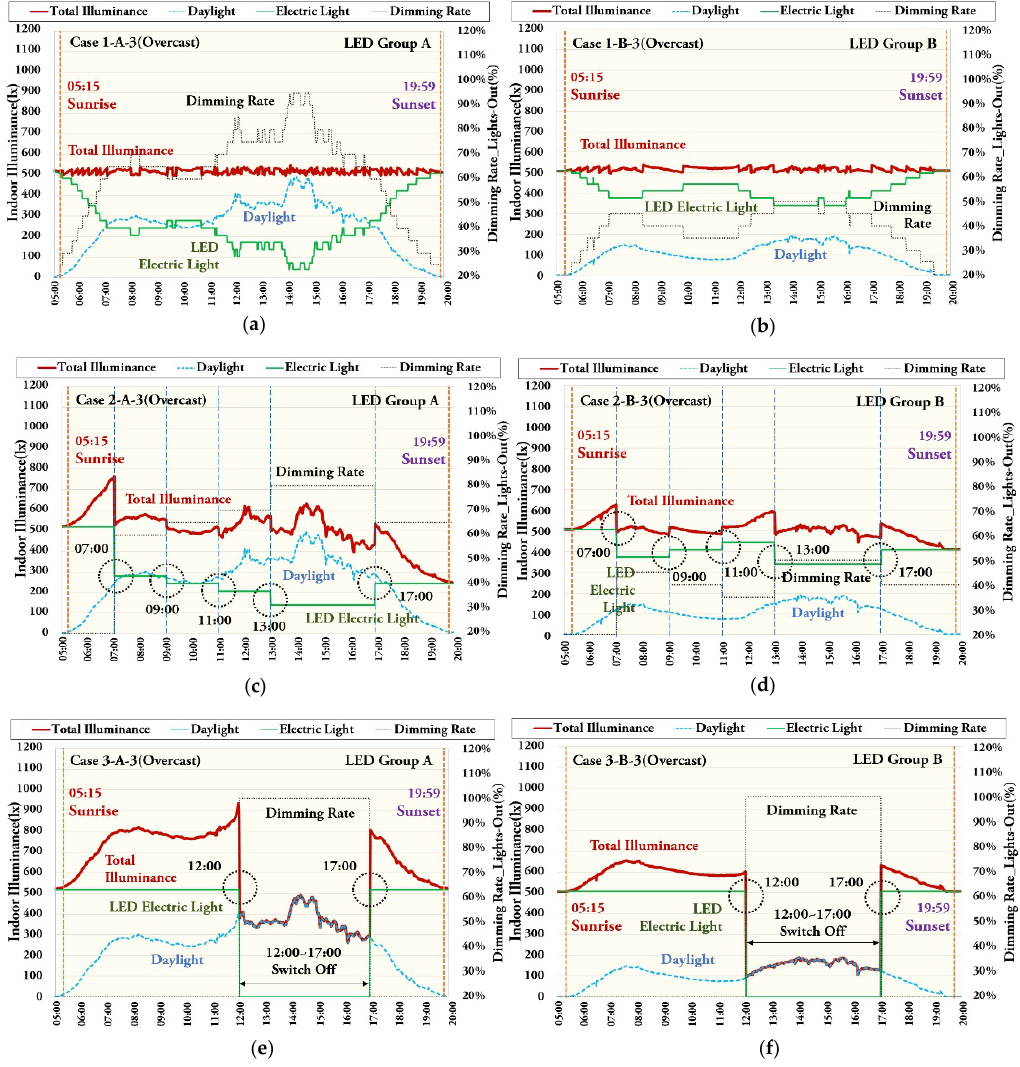
Figure 14. Illuminance and dimming rate under dimming control with no blind (overcast sky_07.06). ( a ) Case 1-A-3, ( b ) Case 1-B-3, ( c ) Case 2-A-3, ( d ) Case 2-B-3, ( e ) Case 3-A-3, and ( f ) Case 3-B-3 in Table 5.